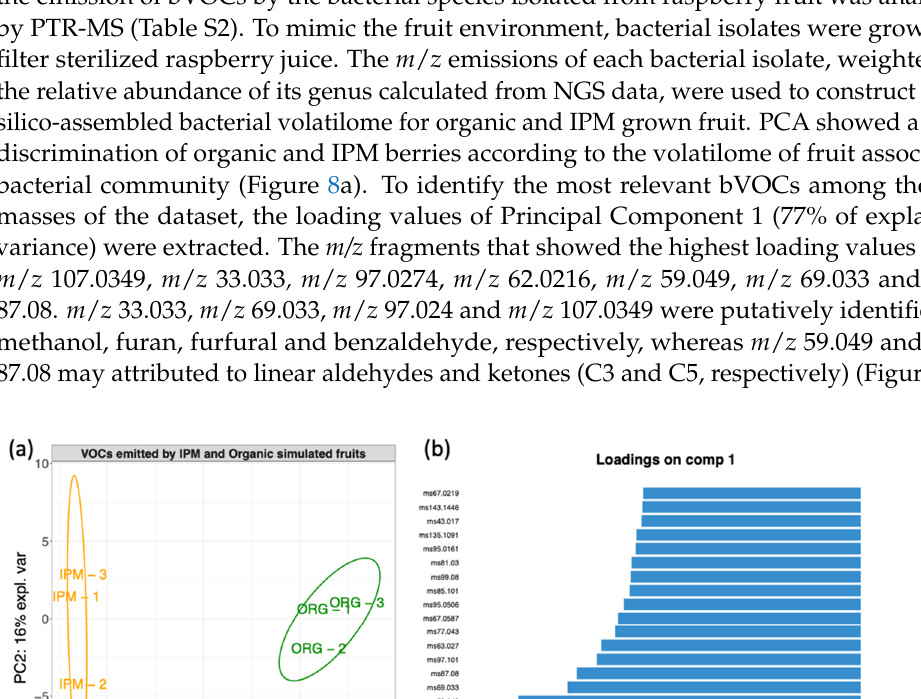
Figure 7. Canonical correlation analysis of bacterial genera discriminating organic from IMP grown fruit and volatile organic compounds classes. Bacterial genera are coloured in brown, volatile organic compounds classes in green.